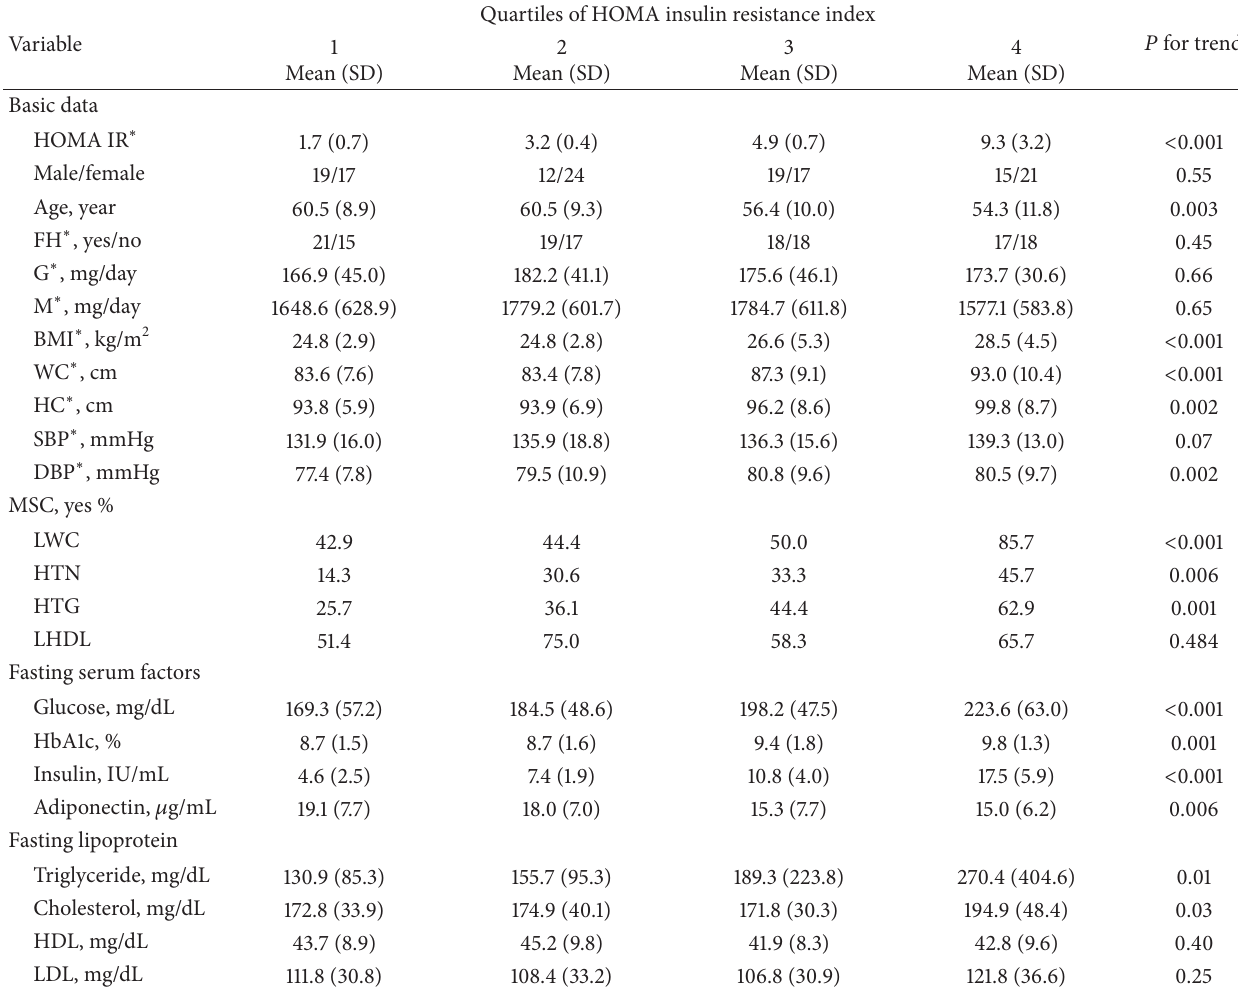
Table 1: Comparison of characteristics among quartiles of HOMA insulin resistance